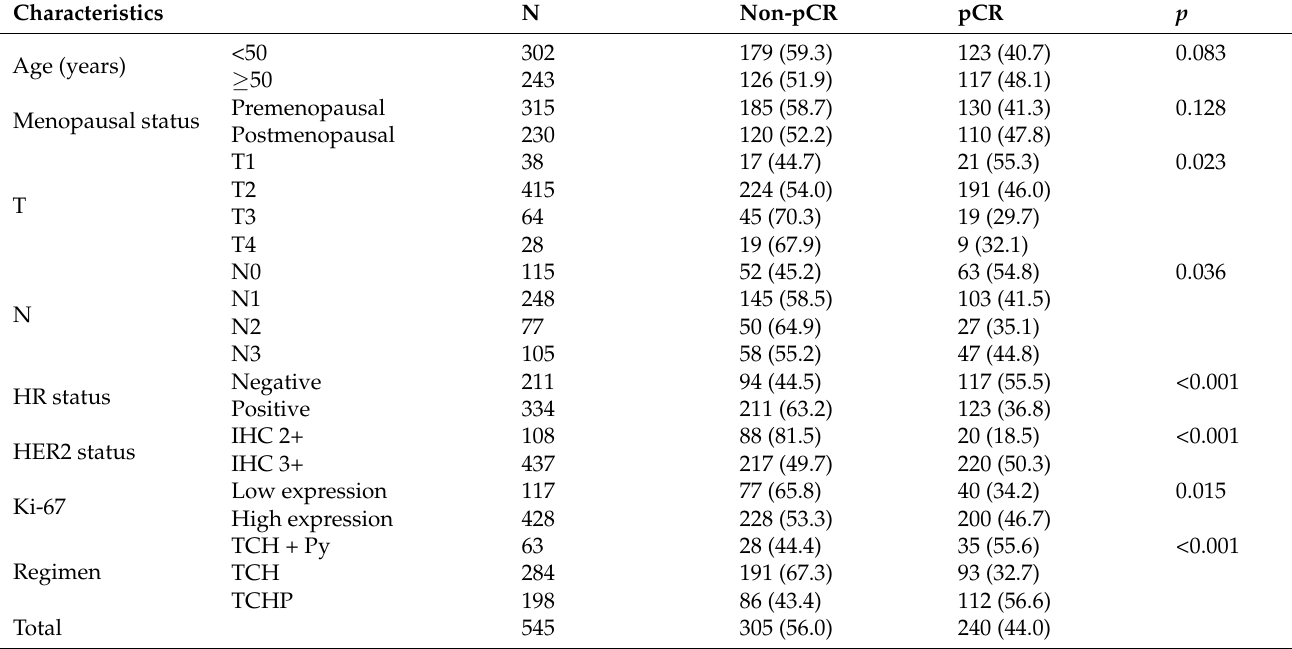
Table 2. Univariate analyses of factors associated with